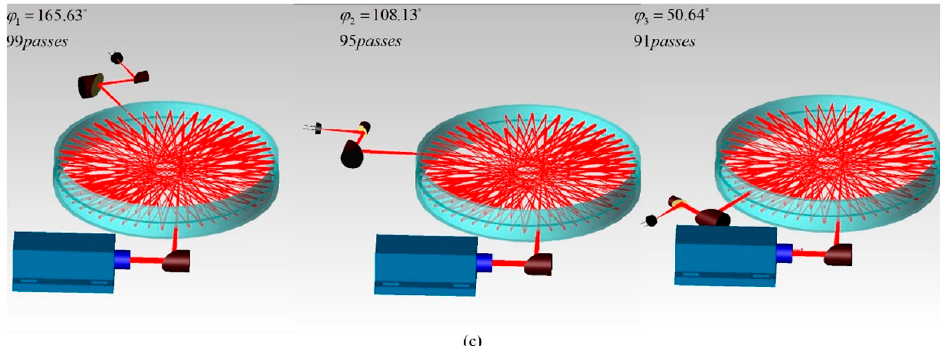
Figure 7. Simulations of overall optical systems based on DR-CMPC, with parameters of R = 125 mm, c = 4.4 mm and ( a ) p = 150, q = 73 and ϕ 1 = 175.21 ◦ corresponding to 299 passes, 74.72 m effective OPL; ϕ 2 = 156.04 ◦ corresponding to 295 passes, 73.72 m; and ϕ 3 = 136.88 ◦ corresponding to 291 passes, 72.72 m; ( b ) p = 98, q = 47 and ϕ 1 = 172.67 ◦ corresponding to 195 passes, 48.67 m; ϕ 2 = 143.33 ◦ corresponding to 191 passes, 47.68 m; and ϕ 3 = 136.88 ◦ corresponding to 187 passes, 46.68 m; ( c ) p = 50, q = 23 and ϕ 1 = 165.63 ◦ corresponding to 99 passes, 24.57 m; ϕ 2 = 108.13 ◦ corresponding to 95